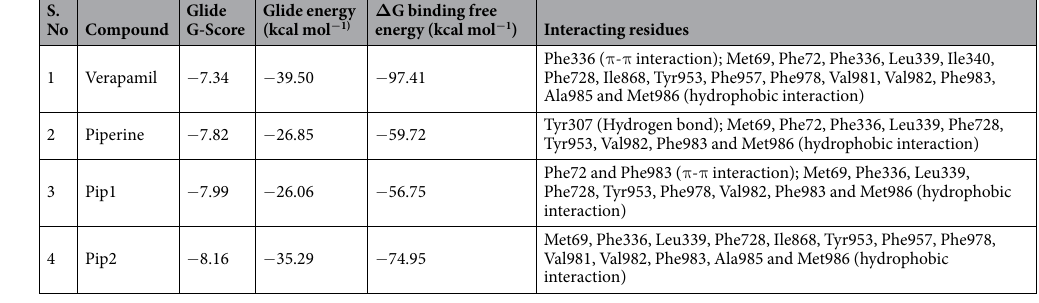
Table 1. Docking analysis of P-gp with verapamil, piperine and piperine analogs (Pip1 and